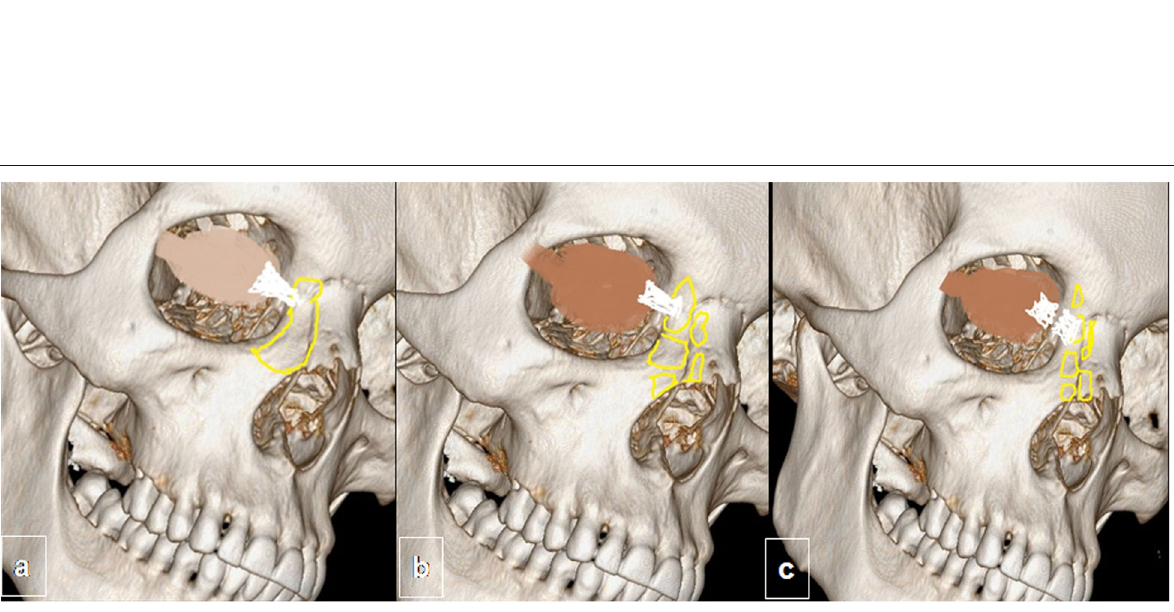
Fig. 9 Classification of naso-orbito-ethmoidal fractures. Three dimensional CT images of an adult skull with color overlays depict the Markovitz and Manson classification: type I ( a ) characterized by a single large fragment with attached medial tendon; type II ( b ) with bone comminution without extension to the medial canthal tendon; and type III ( c ), where comminution affects the medial canthal